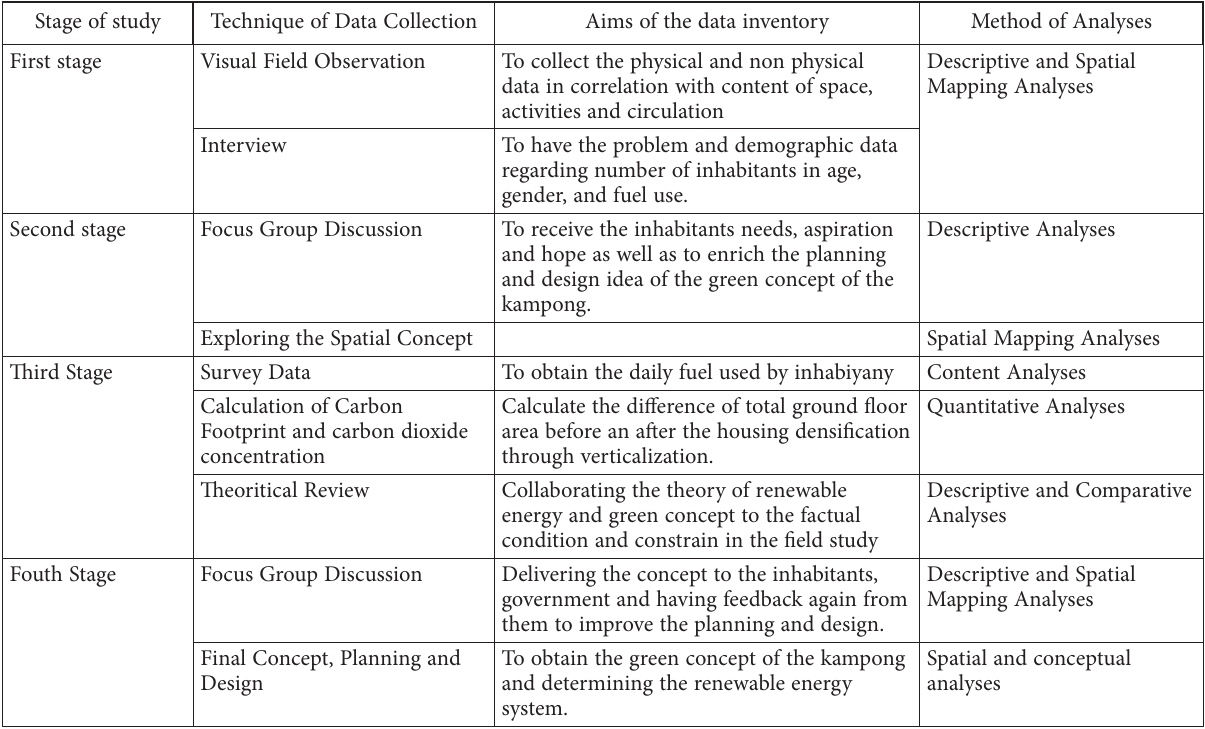
Table 1. The Stages of study, the data collection and data